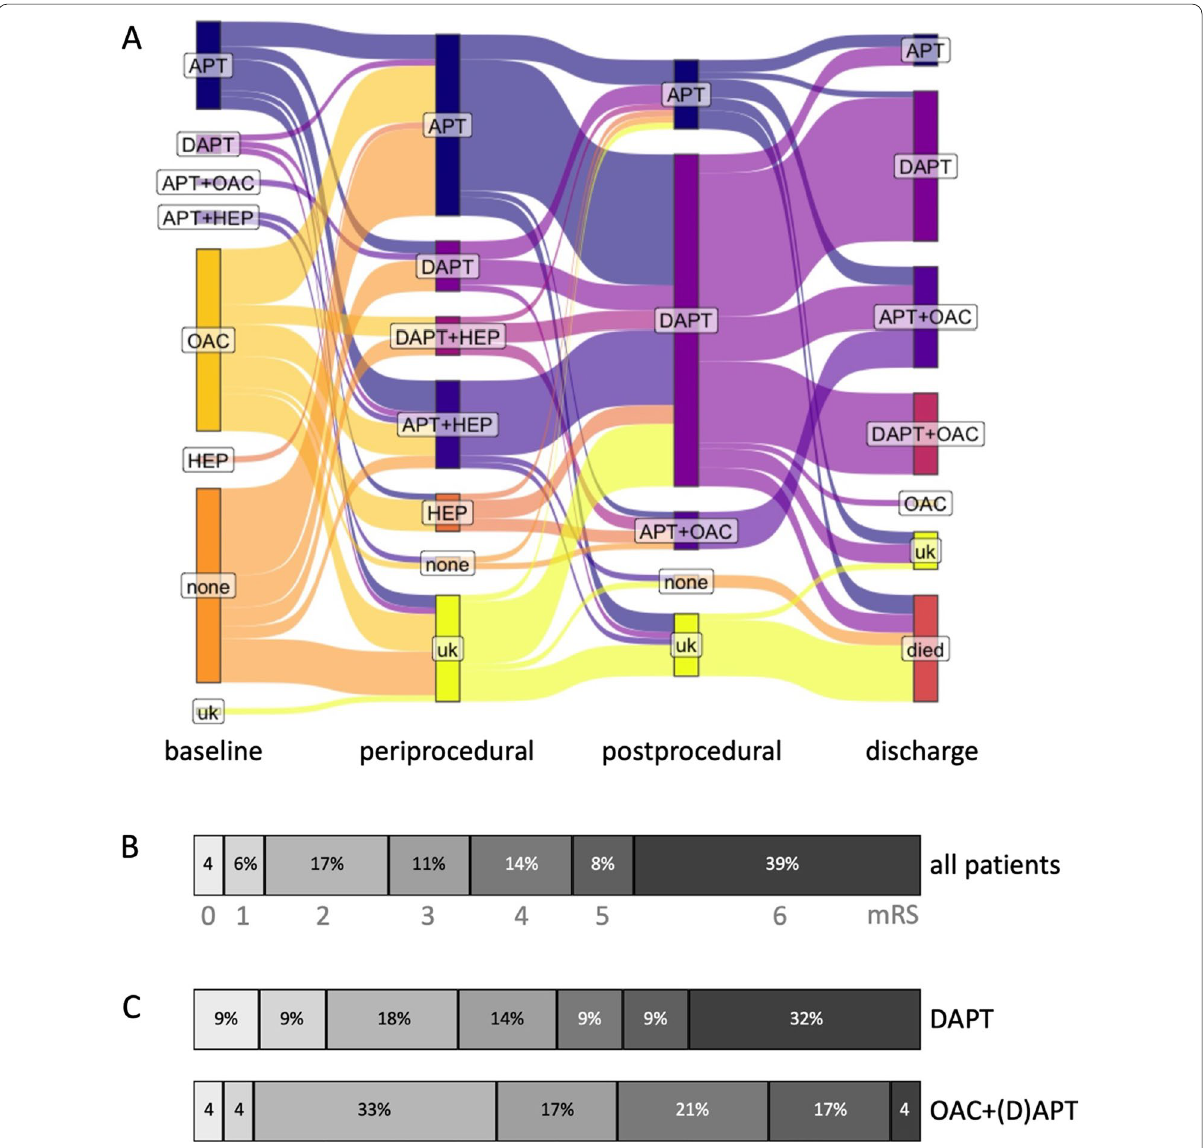
Fig. 1 Antithrombotic medication and outcome at 90-day follow-up. A Sankey diagram of antithrombotic medication upon baseline, periprocedural, postprocedural and at discharge. B Functional outcome of stroke patients with atrial fibrillation after endovascular treatment and carotid artery stenting at 90-day follow-up (n 82). C Comparison of functional outcome for patients discharged with dual antiplatelet therapy = (n 24) compared to patients with oral anticoagulation in addition to antiplatelet therapy (n 29), see respective groups at ‘discharge’ in Panel A. = = Abbreviations: APT, antiplatelet therapy; DAPT, dual antiplatelet therapy; OAC, oral anticoagulation, HEP, therapeutic dosing of heparin; uk,